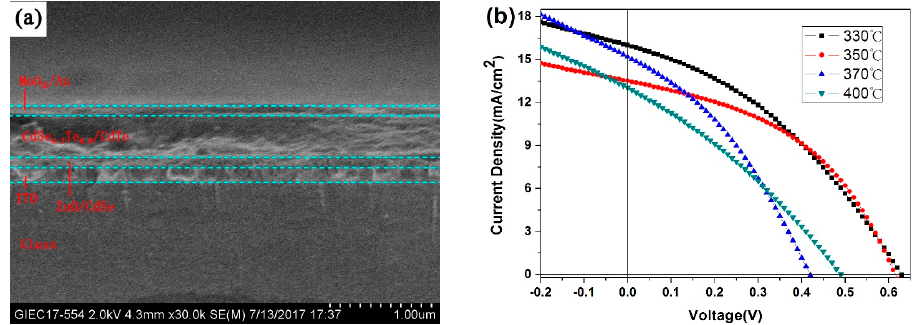
Figure 4. ( a ) Cross-section SEM image of the glass/ITO/ ZnO/CdSe/CdSe 0.2 Te 0.8 /CdTe/Au/MoO x device and ( b ) J - V characteristics of ITO/ZnO/CdSe/CdSe 0.2 Te 0.8 /CdTe/Au/MoO x devices with different annealing temperatures under light. Table 2. Summarized performances of CdSe 0.2 Te 0.8 NC solar cells with different annealing temperatures (Figure 4b).